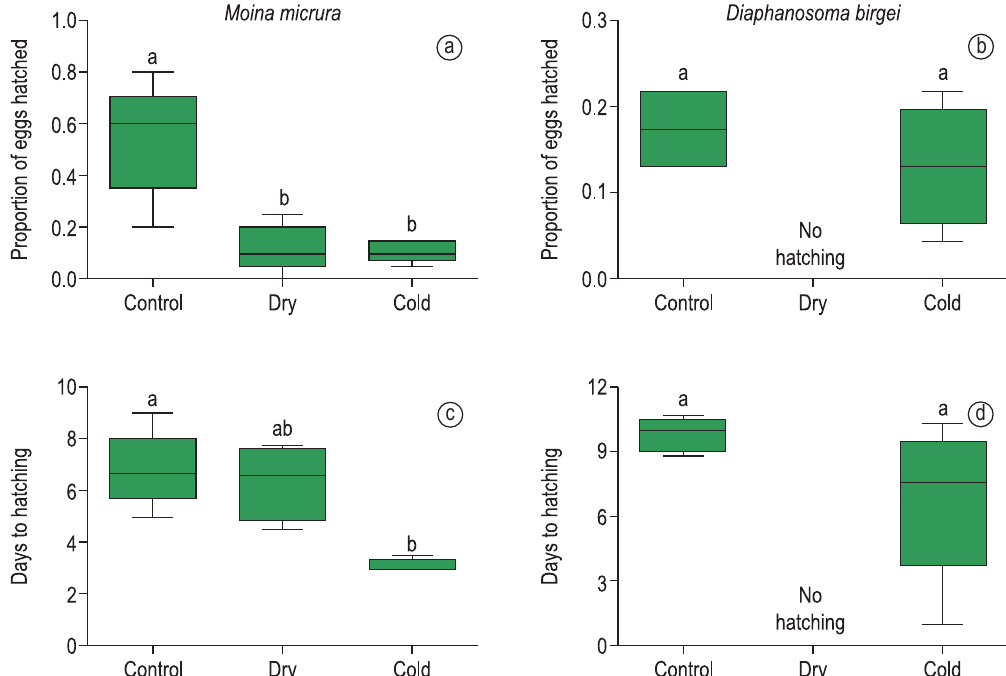
Figure 1. Box and Whisker plots of the hatching responses of Moina micrura and Diaphanosoma birgei resting eggs under the experimental conditions. Internal lines stand for medians, the top and bottom of each box stand for the third and first quartiles, respectively; the whiskers are the lines reaching the smallest and largest values. Different letters above boxes denote significant differences between treatments. See text for further